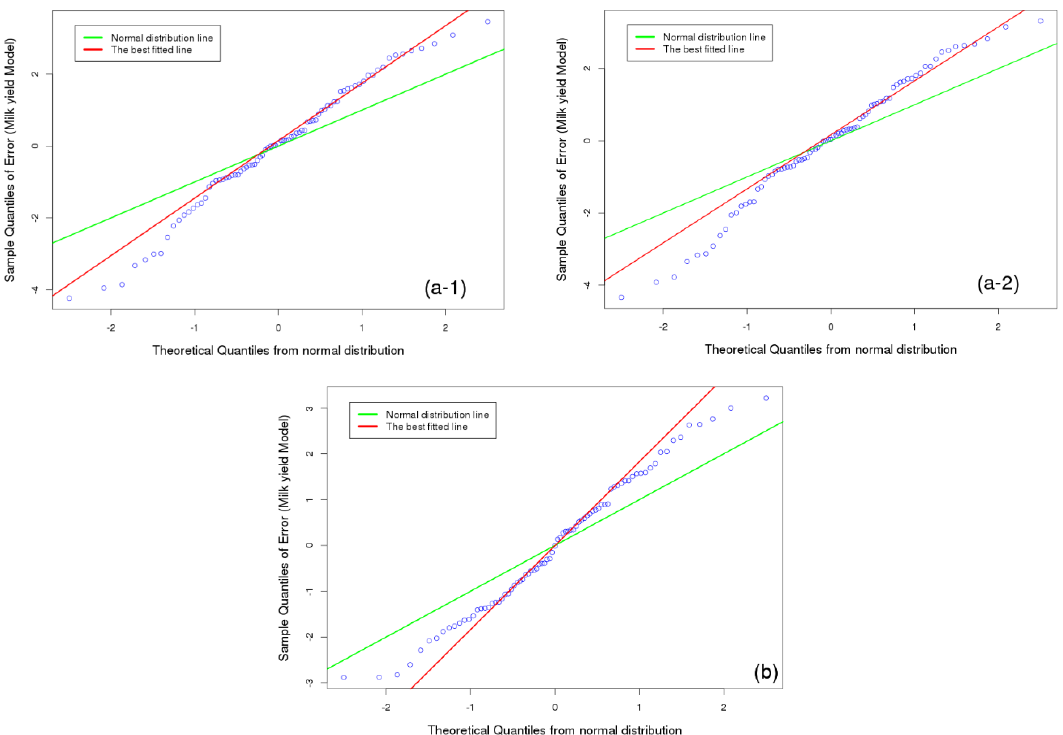
Figure 6. Quantile-Quantile (Q-Q) plot of the best models for milk yield in spring ( a ) and summer ( b ).